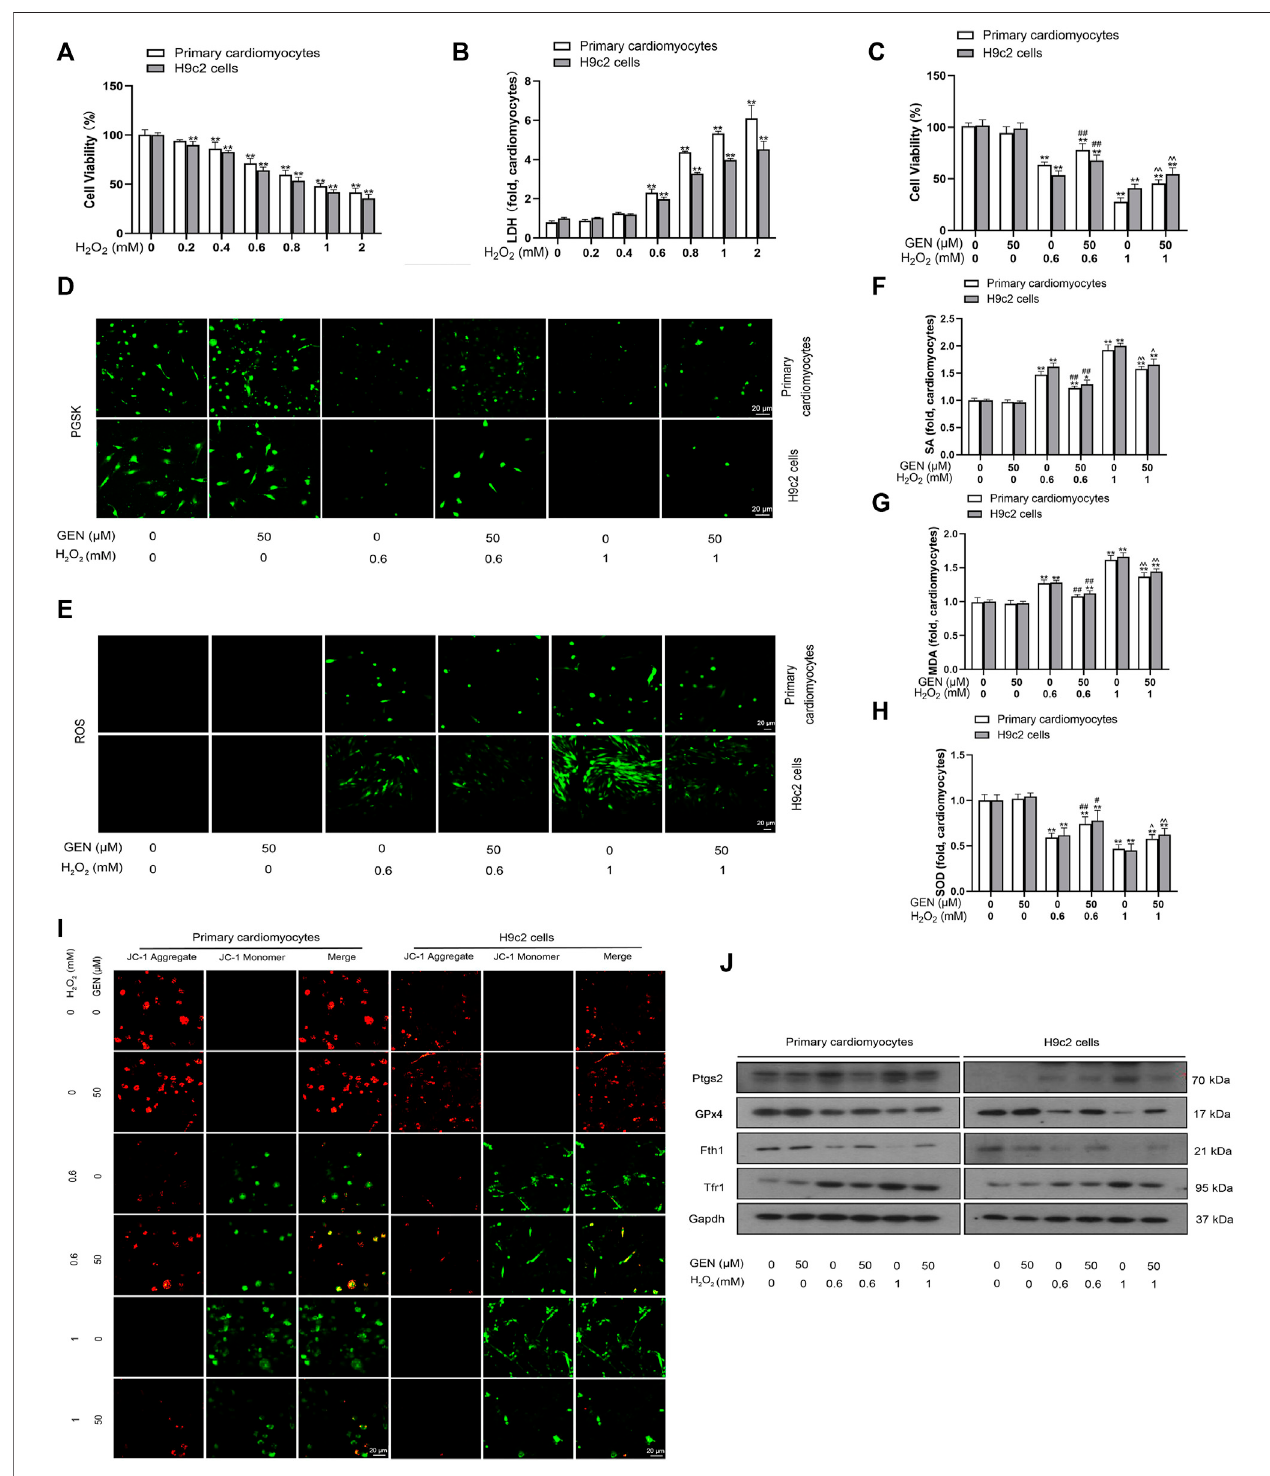
FIGURE 2 | GEN rescues H 2 O 2 -induced ferroptosis injury in cardiomyocytes. (A,B) Viability and toxicity of primary cardiomyocytes and H9c2 cells treated by different concentrations of H 2 O 2 for 24 h. (C) Viability of cardiomyocytes treated with 50 μ m GEN after pretreatment with 0.6 or 1 mM H 2 O 2 . (D) Effect of GEN on iron accumulation in H 2 O 2 -induced cells. (E – H) Effects of GEN on lipid ROS, SA, MDA, and SOD levels in H 2 O 2 -induced cells. (I) JC-1 fl uorescence in H 2 O 2 -induced cardiomyocytes treated with GEN. (J) Protein expression levels of Ptgs2, GPx4, Fth1, and Tfr1 in H 2 O 2 -induced cells treated with GEN. Data were expressed as mean ± SD ( n = 5). * p < 0.05, ** p < 0.01 vs. Control group; # p < 0.05, ## p < 0.01 vs. 0.6 mM H 2 O 2 group; ^ p < 0.05, ^^ p < 0.01 vs. 1 mM H 2 O 2 group. Scale bar = 20 µm.